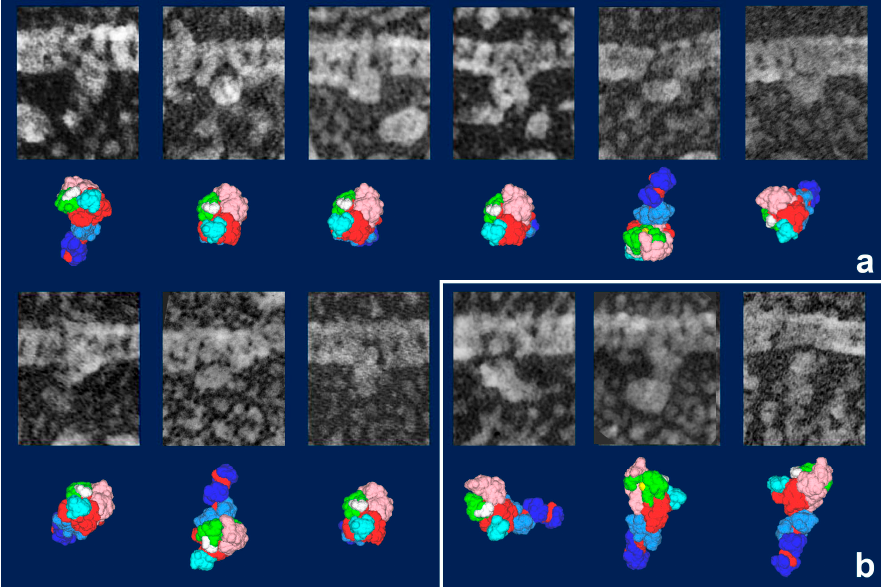
Figure 4. Gallery of HMM heads attached to actin filaments during sliding, observed in a quick-freeze replica, with the most likely simulation model for each. Model images indicate the best-matched views among the candidate models together with their subdomain arrangement shown as color-coded. ( a ) Particles judged as in “weakly bound state”. Note that the lever arm portions are not visible in most of the particles. They are hidden beneath an adjacent actin filament or S1’s own body to give globally rounded appearance. The thiol-crosslinked configuration (Figure 3a) is the only model that explains those images. It is also notable that the plane, including upper and lower 50 KDa subdomains, is oriented parallel to the main axis of actin filament, whereas the first actin contact site (yellow patch in Figure 3) is facing the actin side and the second contact site (white patch) is directed to the opposite side, suggesting that these particles are searching for a good clutch site on actin [33]; ( b ) Particles assigned as Vi-type. Their orientations are variable [18]. Scale bars exhibit 10 nm.